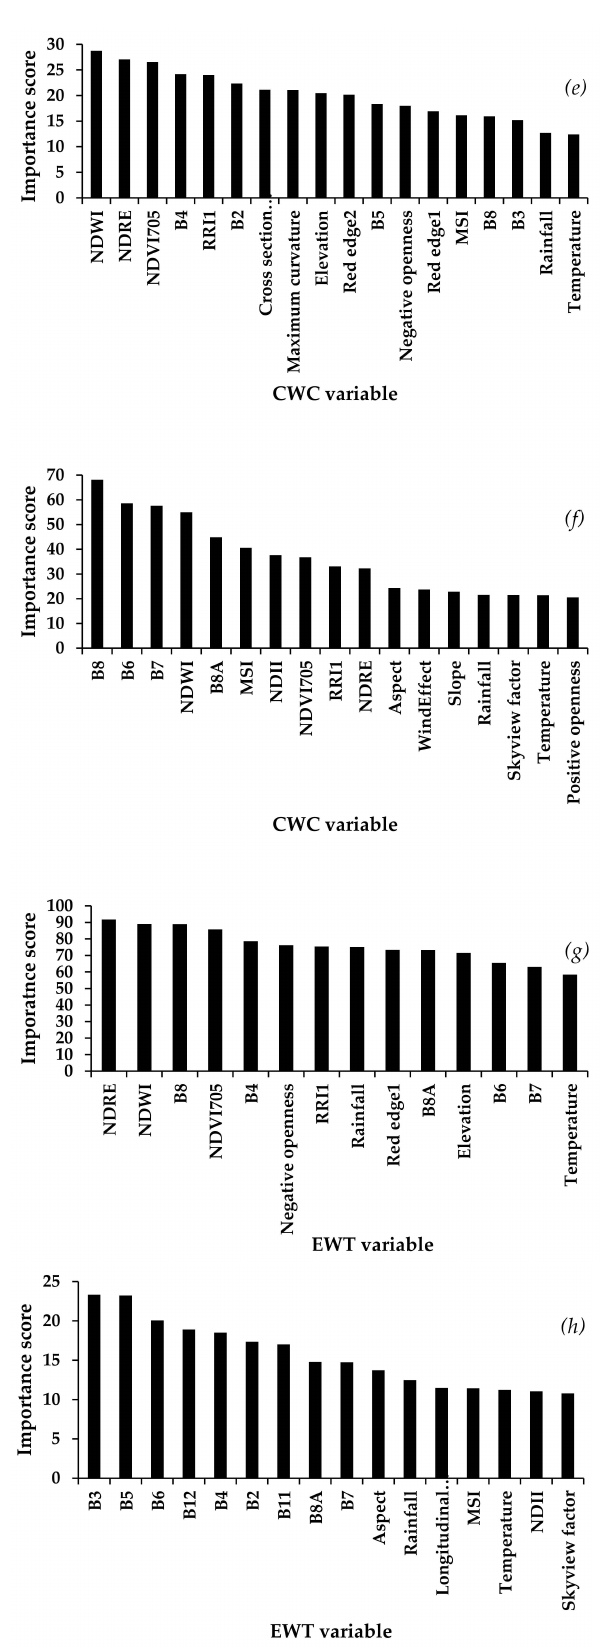
Figure 4. Variable importance scores of selected variables in estimating ( a , b ) LAI, ( c , d ) CSC, ( e , f ) CWC, and ( g , h ) EWT for wet and dry seasons,